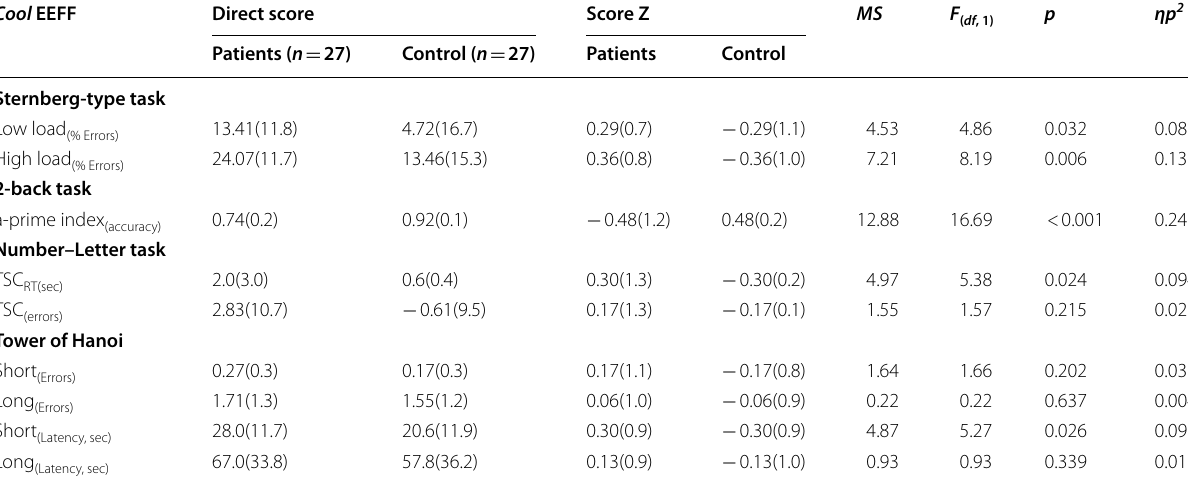
Table 3 Cool EEFF. Descriptive statistics. M(SD) of transformed score Z and multivariate (MANOVA) results for patients and